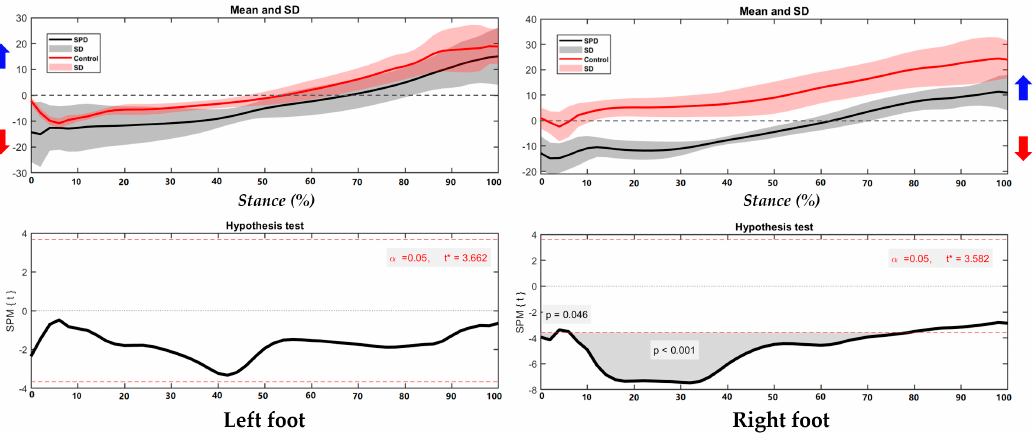
Figure 4. The COP of trajectory in the left foot and right foot during right/left turning with high- lighted direction of pronation (blue arrow) and supination (red arrow).